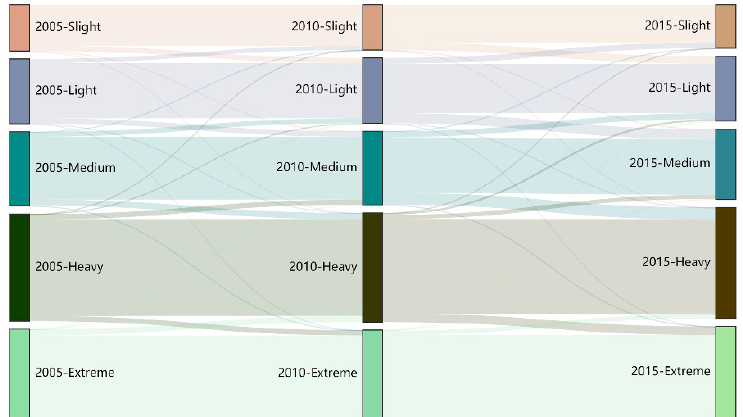
Figure 4. Area conversion of ecosystem vulnerability grades on the Qinghai-Tibet Plateau in 2005, 2010 and 2015.